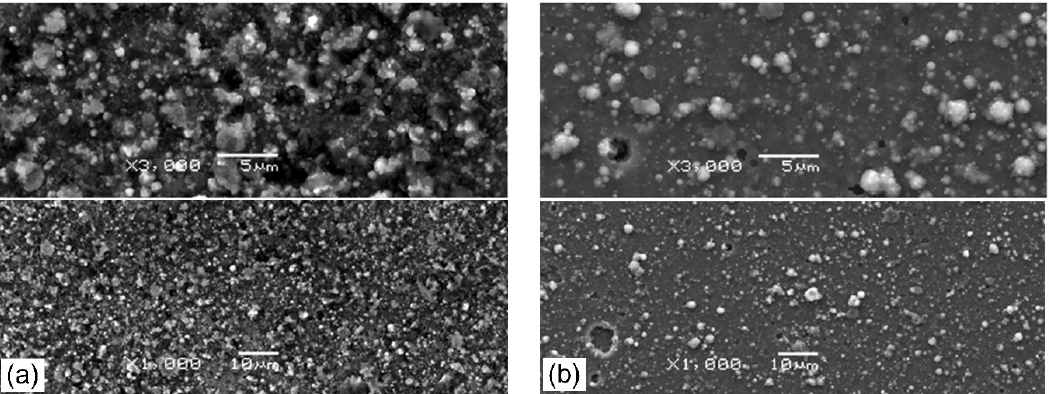
Figure 5. Morphology of of AlCrN coatings synthesized at: ( a ) p N2 = 0.8 Pa and ( b ) p N2 = 5 Pa. Each picture shows the area recorded at magnification: 1000 × ( bottom ) and 3000 × ( top ).